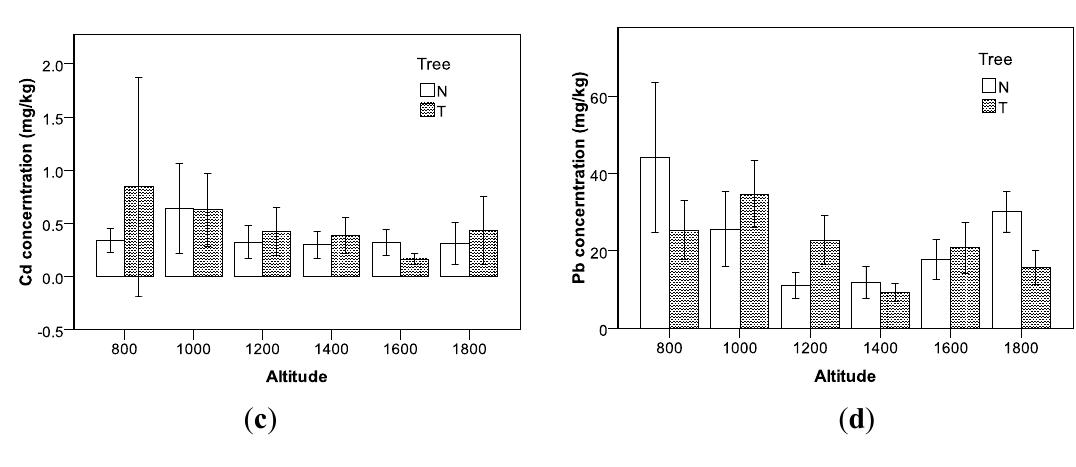
Figure 7. Variation in soil heavy metal concentrations with